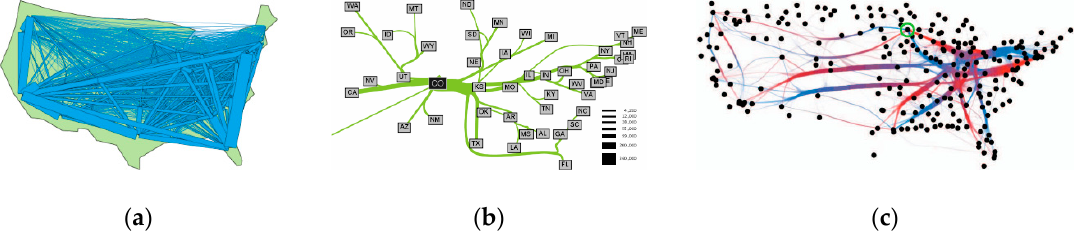
Figure 49. Flow-map visualizations at an early stage: ( a ) migration flow map of the United States Census [128]; ( b ) migration map of outflows from Colorado by using edge routing [129]; and ( c ) domestic flights in the United States by using the edge-bundling technique [130].